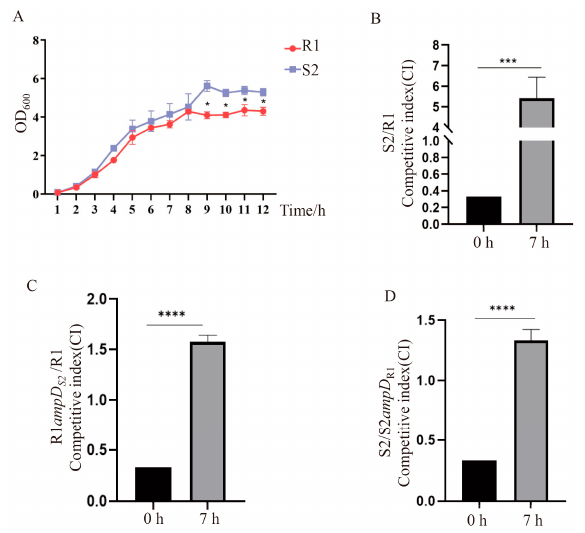
Figure 2. Fitness advantage of the S2 strain compared to the R1 strain. ( A ) Growth curves of R1 and S2 strains in L-broth medium. *, p < 0.05, by Student’s t test. ( B – D ) Competitive advantages of S2 over R1 ( B ), R1 ampD S2 over R1 ( C ), and S2 over S2 ampD R1 ( D ). Two bacterial strains, R1 and S2, R1 and R1 ampD S2 , or S2 ampD R1 and S2, were each mixed at a 3:1 ratio, co-incubated for 7 h at 37 °C, and plated on L-agar plates with or without piperacillin. The competitive indexes in ( B – D ) represent the ratio of recovered bacterial number (S2, R1 ampD S2 , or S2) to the respective number of recovered R1, R1, or S2 ampD R1 strains. Bars represent the means from three tests, and error bars indicate the standard deviation. ***, p < 0.001, ****, p < 0.0001, by Student’s t test.